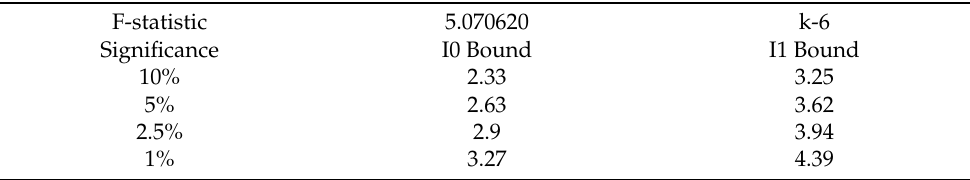
Table 6. NARDL Bounds Test